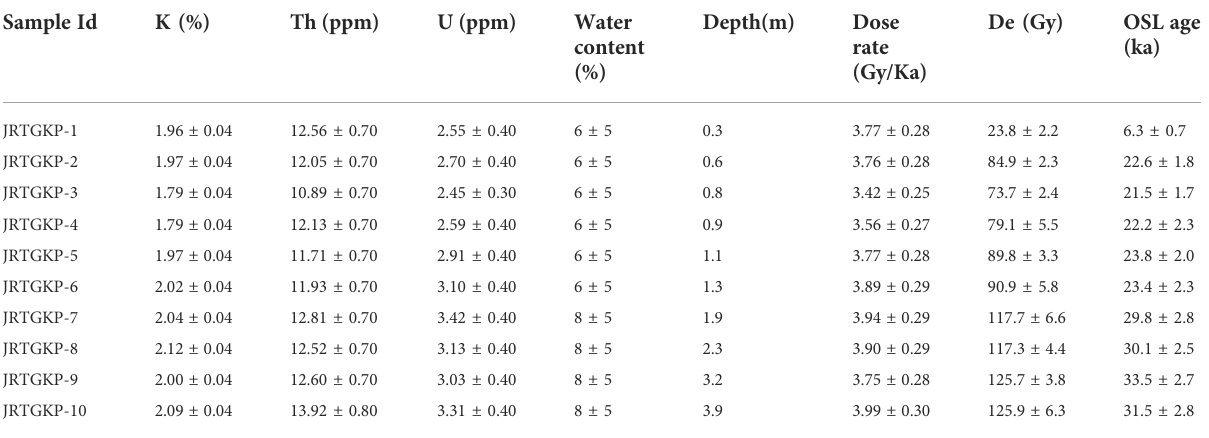
TABLE 1 OSL dating results of samples from the JRT section. Sample